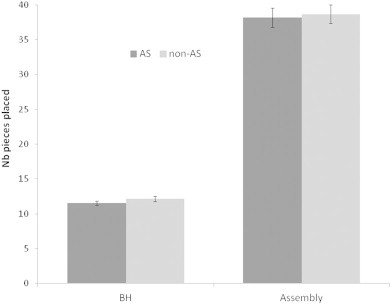
Results of the Purdue pegboard “both hands” (BH) and “assembly” conditions for autism spectrum (AS) and non-autism spectrum (non-AS) participants. The number of pieces placed in 30 (BH) and 60 (assembly) seconds is displayed. Error bars represent standard errors.